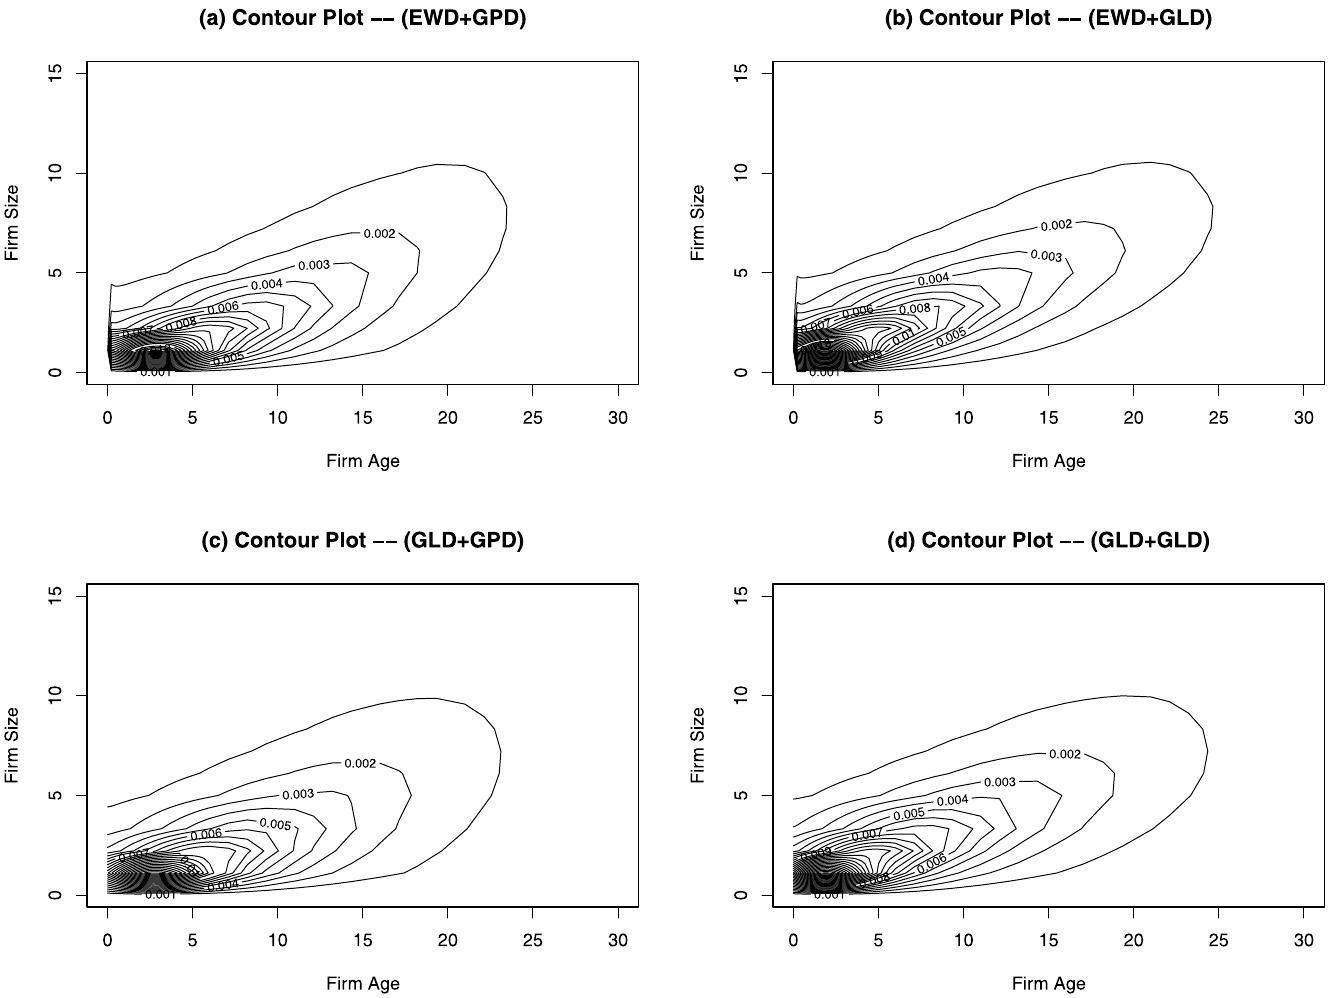
Fig 5. Estimated joint distribution of firm age and firm size for 2014 US private-sector firms. Plots (a) and (b), the marginal distribution of firm age is estimated by using EWD. Plots (c) and (d), the marginal distribution of firm age is estimated by using GLD. Plots (a) and (c), the marginal distribution of firm size is estimated by using GPD. Plots (c) and (d), the marginal distribution of firm size is estimated by using GLD.